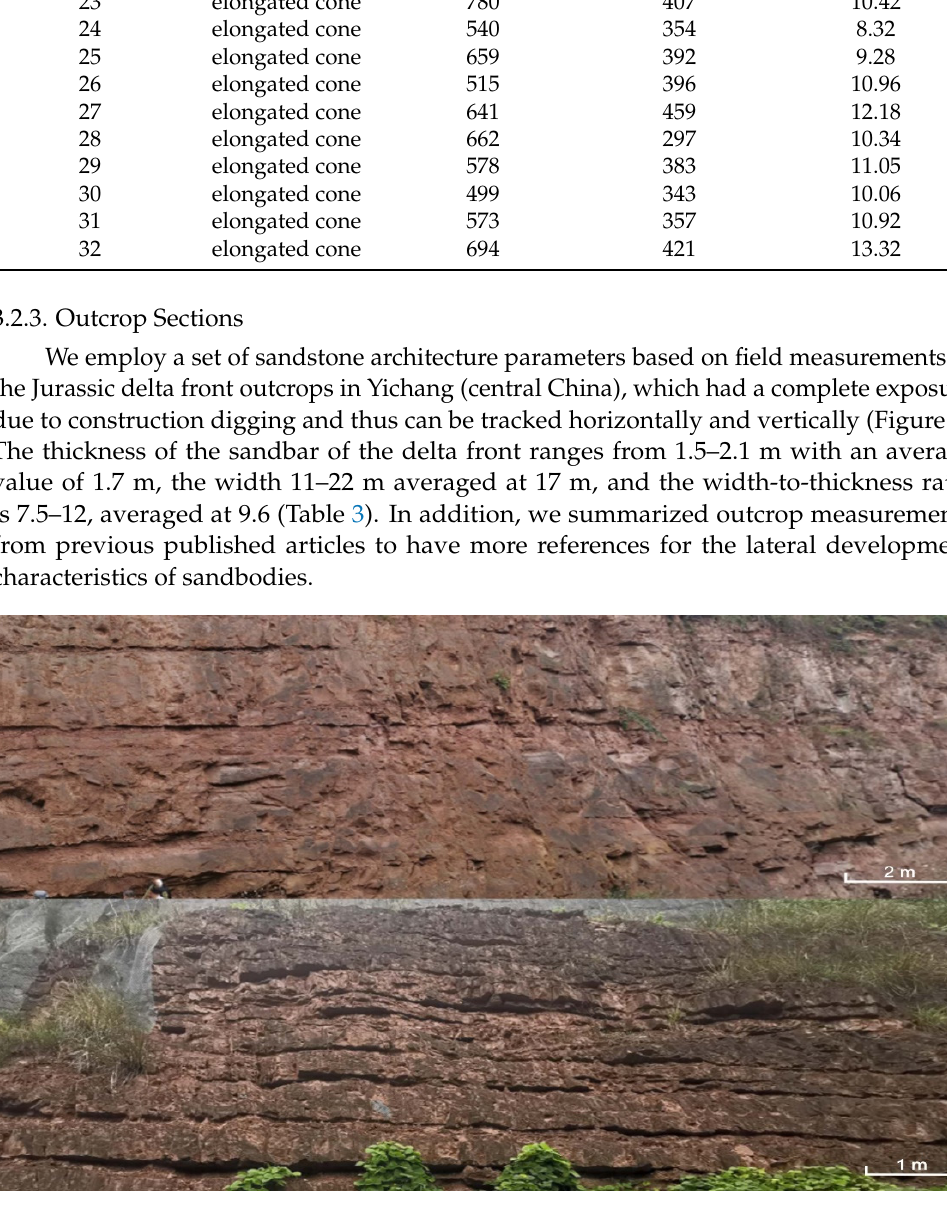
Figure 6. Jurassic delta outcrop in Yichang.